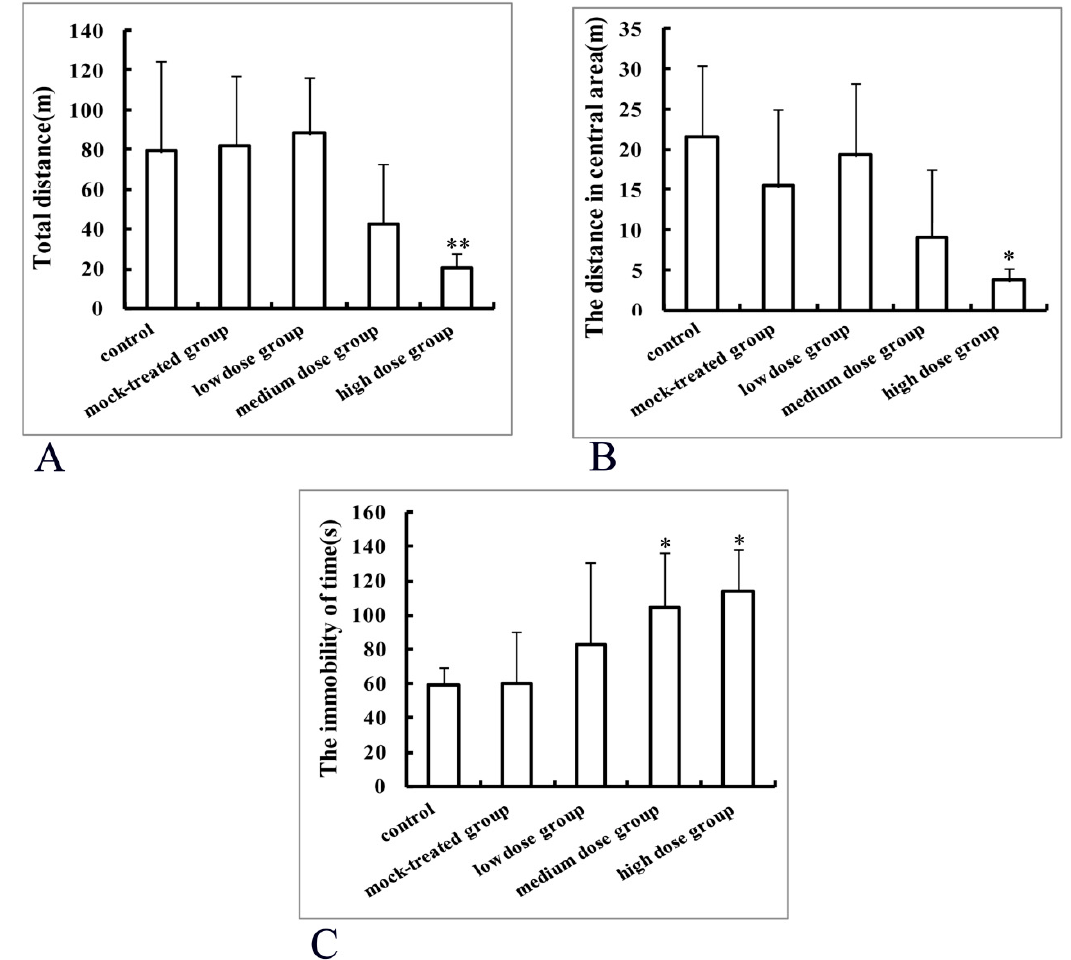
Figure 10. Behavioral effects of maternal exposure to PM 2.5 during pregnancy on mice offspring in open field test ( A , B ) and tail suspension experiment ( C ). * p < 0.05, compared with control; ** p < 0.01, compared with control.